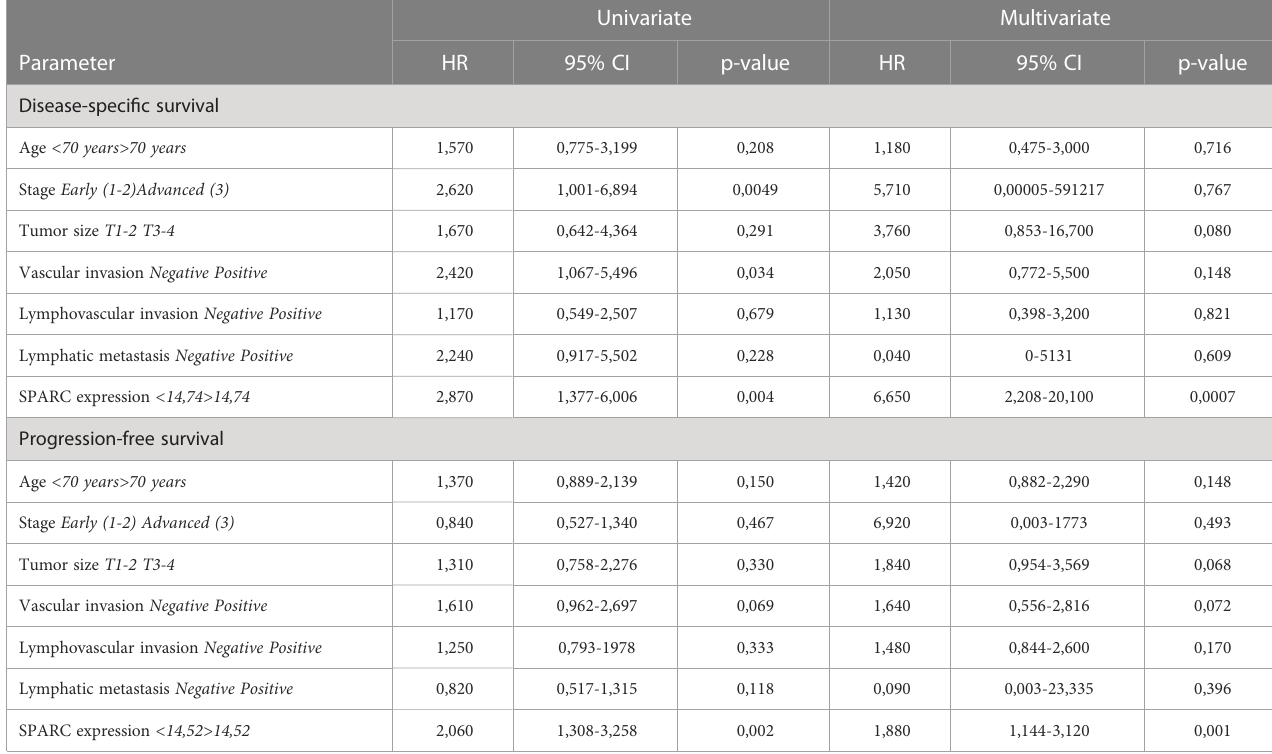
TABLE 3 The prognostic signi fi cance of SPARC mRNA levels in patients with CRC revealed by univariate and multivariate COX analysis.